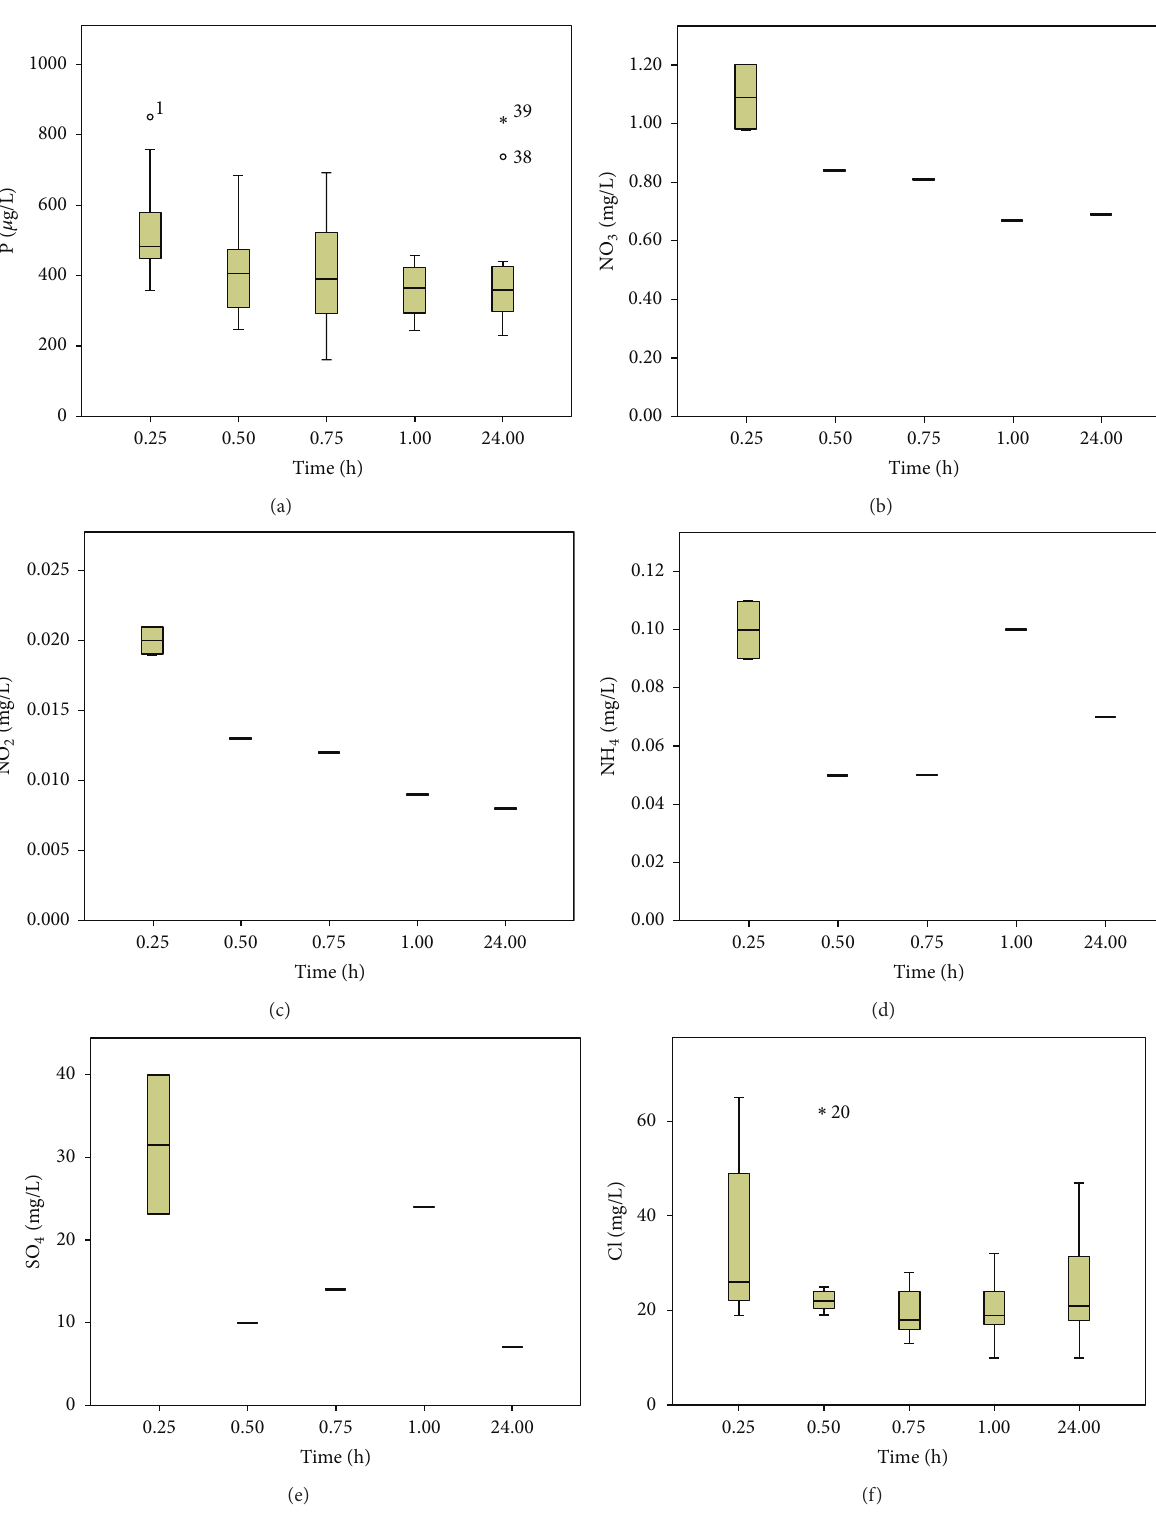
Figure 3: Micropollutant (P, NO 3 , NO 2 , NH 4 , SO 4 , and Cl) variations in runoff samples without the first flush sample in Area A (but with the 50 samples per sampling